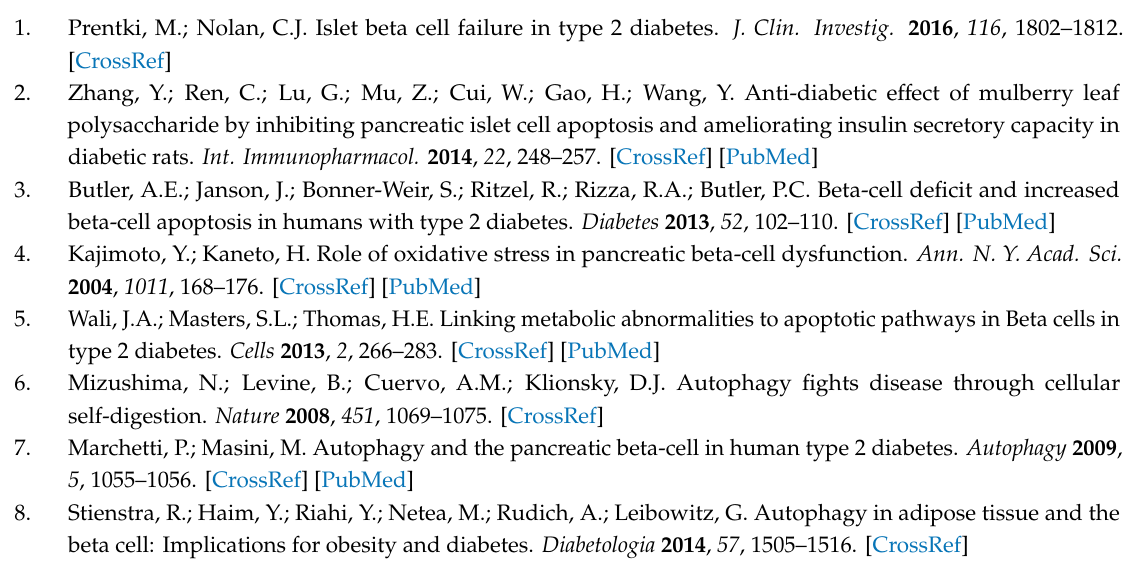
Figure S1: Flow chart of HFD combined STZ treatment-induced DM mice treated with LSE (1% and 2%) or metformin (300 mg / kg) for 6 weeks, Figure S2: E ff ect of Q3G on H 2 O 2 -induced beta-cell viability loss and oxidative injury, Figure S3: E ff ect of Q3G on H 2 O 2 -induced beta-cell apoptosis, Figure S4: E ff ect of Q3G on H 2 O 2 -induced beta-cell autophagy, Table S1: E ff ect of LSE on the serum biochemical parameters of mice induced by an HFD combined with STZ treatment, Table S2: E ff ect of LSE on the organ weight / bodyweight ratio of mice induced by an HFD combined with STZ treatment, Table S3: The protective e ff ect(s) of LSE in comparison to the positive control, metformin, in mice induced by an HFD combined with STZ